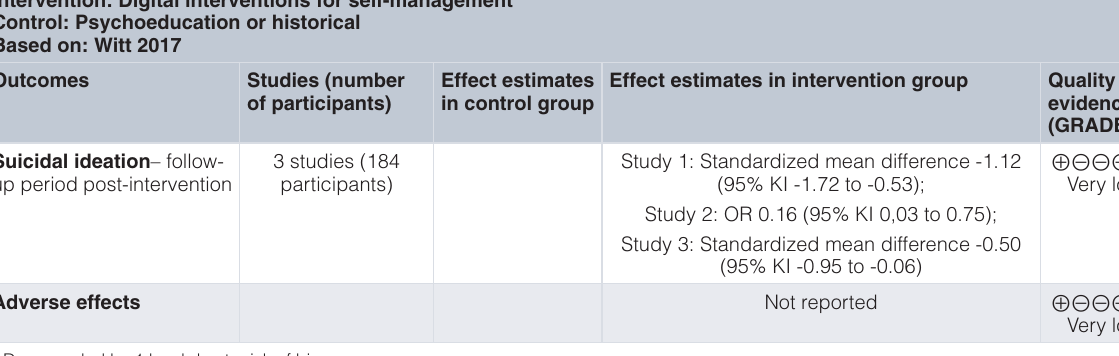
Table 15. GRADE-assessment: Interventions for existing self-harm: digital interventions for self-management versus psychoeducation or historical control. Population: Adolescents with self-reported suicidal ideation or receiving treatment for depression Intervention: Digital interventions for